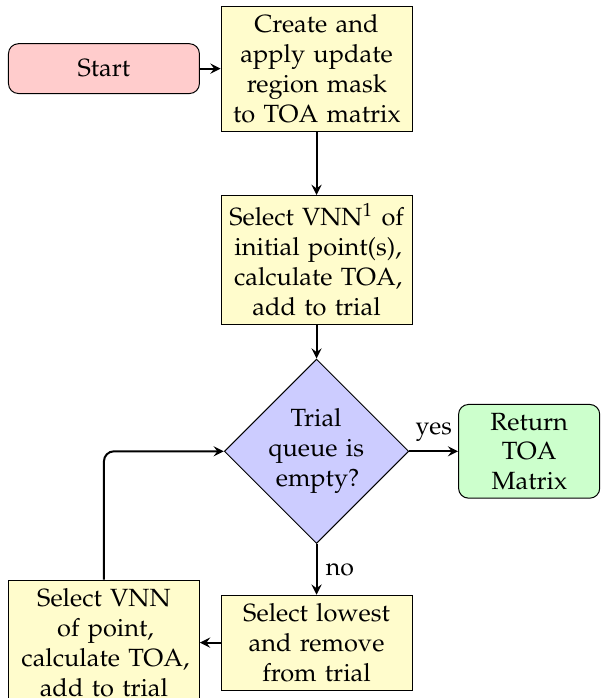
Figure 10. uFMS: Procedure to update TOA